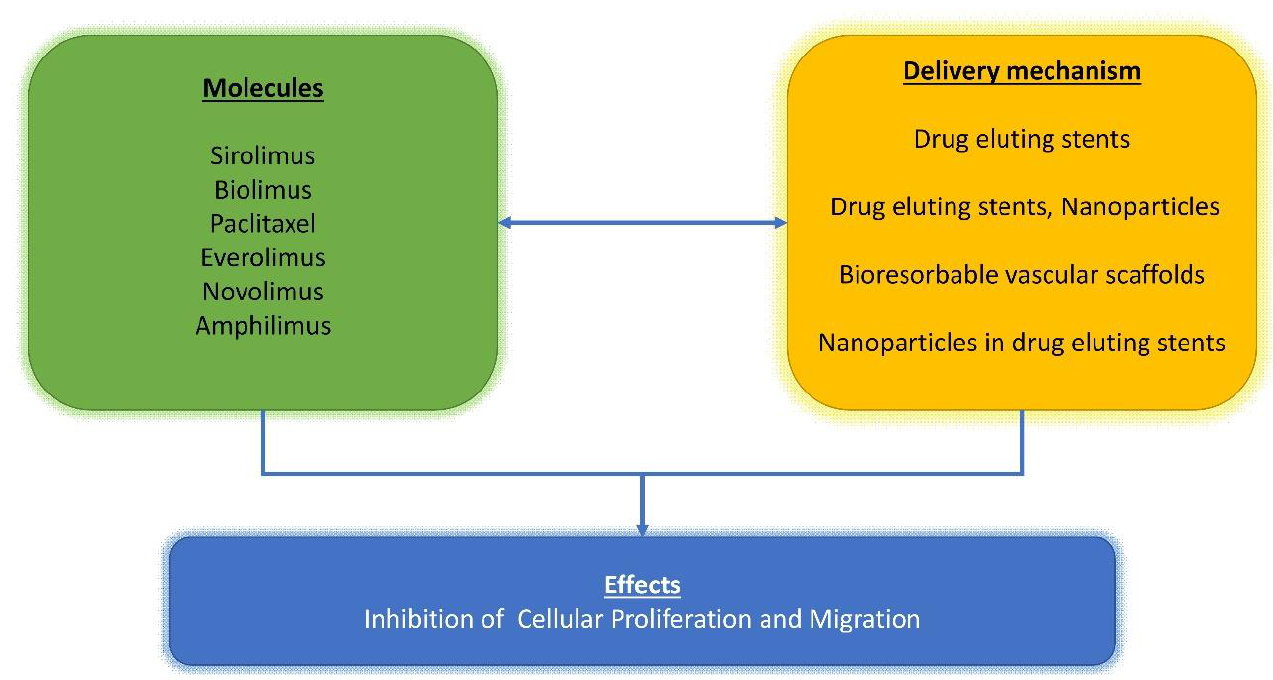
Figure 1. Schematic representation of different pathways described in the text. Effect of sirolimus and similar compounds (biolimus, paclitaxel, everolimus, novolimus, and amphilimus) (green box) and their delivery mechanisms (yellow box) and downstream effects (blue box).